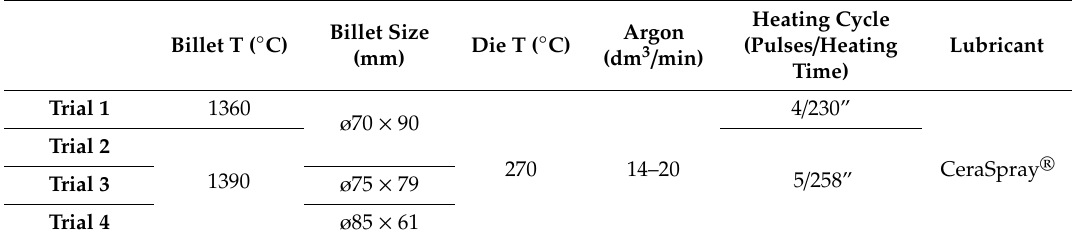
Table 2. Summary of the processing parameters for the conducted experiments.